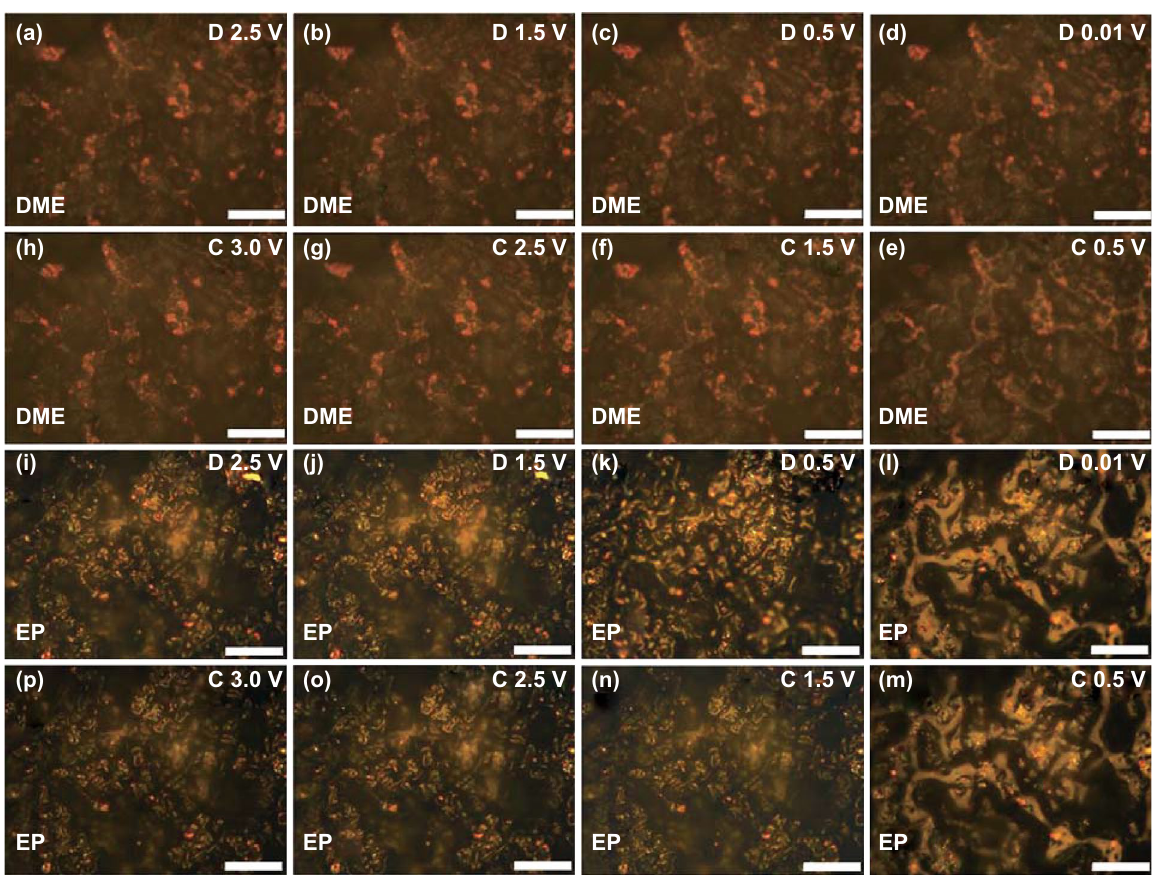
Fig. 4 In situ visualization: a – h different potassiation–depotassiation states of FeSe 2 @RGO electrode using DME-based electrolyte in the first cycle; i – p different potassiation–depotassiation states of FeSe 2 @RGO electrode using EP-based electrolyte in the first cycle. The scale bar in each image is 50